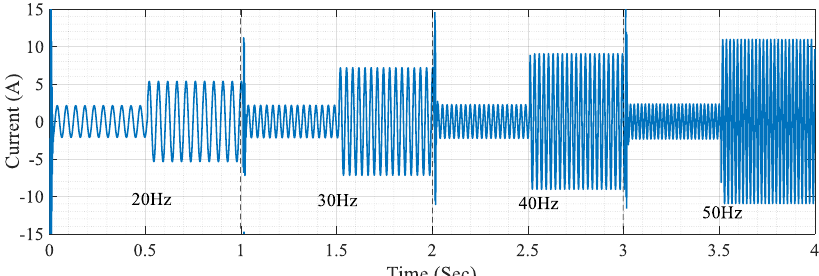
Figure 16. The instantaneous currents of phase A in case of fault at 0.75 A load and 50 Hz frequency.